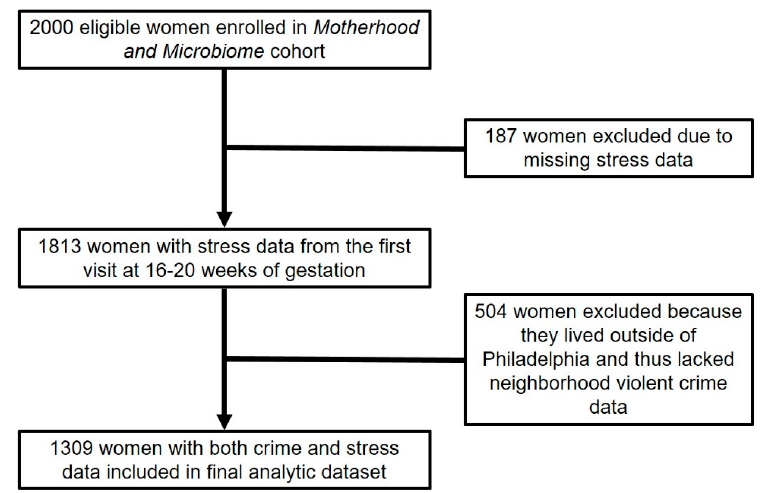
Figure 1. Flowchart of study subjects included and excluded in the analytic dataset.